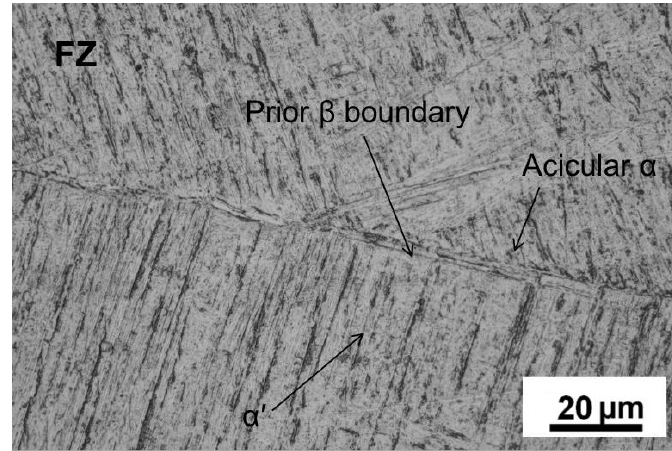
Figure 12. Microstructures of different zones of TIG weldment: ( a ) PM/HAZ/FZ interface and ( b ) FZ.